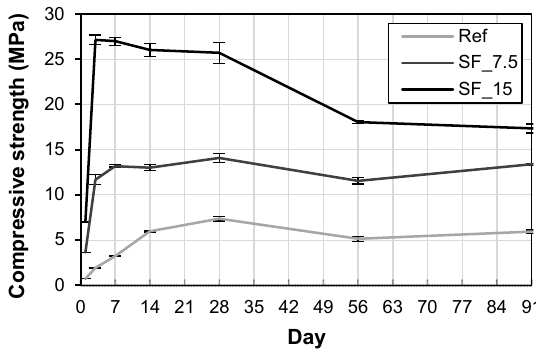
Figure 8. Compressive strength development of kaolinite clay ‐ based mortars.